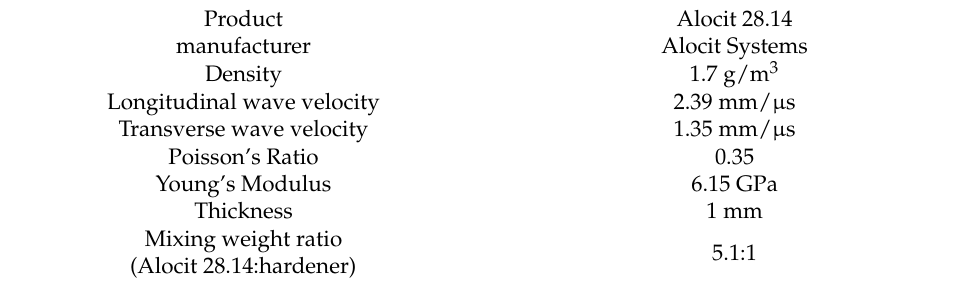
Table 1. Information/Material Properties of the coating materials.